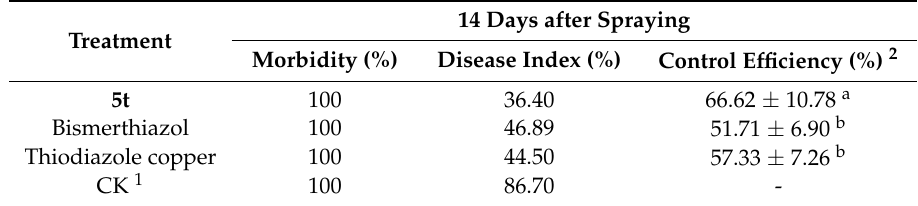
Table 3. Protective activity of compound 5t against rice bacterial leaf blight.